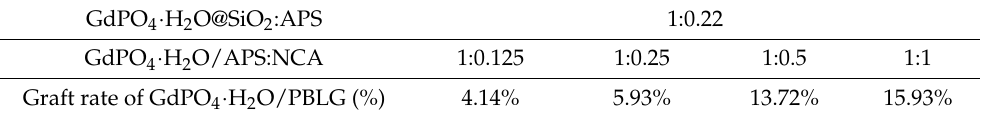
Table 2. The grafting rate of GdPO 4 · H 2 O-PBLG synthesized under different conditions.